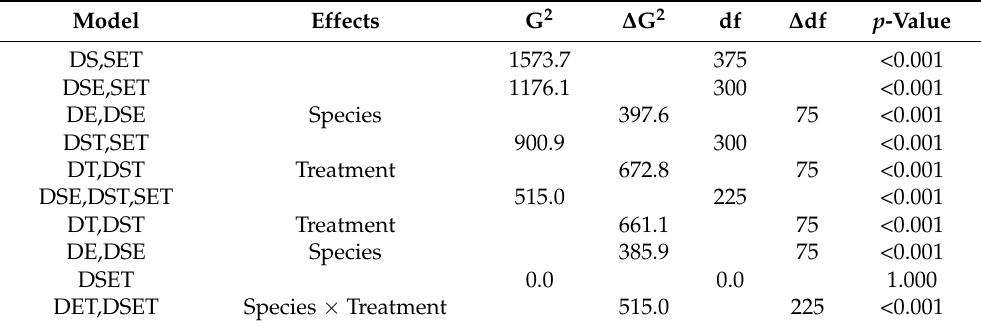
Table 2. Loglinear analysis of the transition frequency table showing the effects of the treatments (T), the species (E) and the interaction on the demographic fate (D) of the four perennial grass species, conditional on the initial state (S). The DS,SET is the null model. This model contains the main effects of species and treatment and the interaction. It also excludes all interaction between fate and any combination of species and treatment. Comparing the null model to the model obtained after adding the species or treatment or the interaction in the null model give the corresponding effect. The log-likelihood ratio (G2) calculated after adding 0.5 to each table cell, as suggested by Fingleton [40], measures the goodness-of-fit of the loglinear model. The variation of G 2 ( ∆ G 2 ) assesses the significance of the observed effects. The degree of freedom (df) is the difference between the number of cells in the table and the number of parameters in the model.